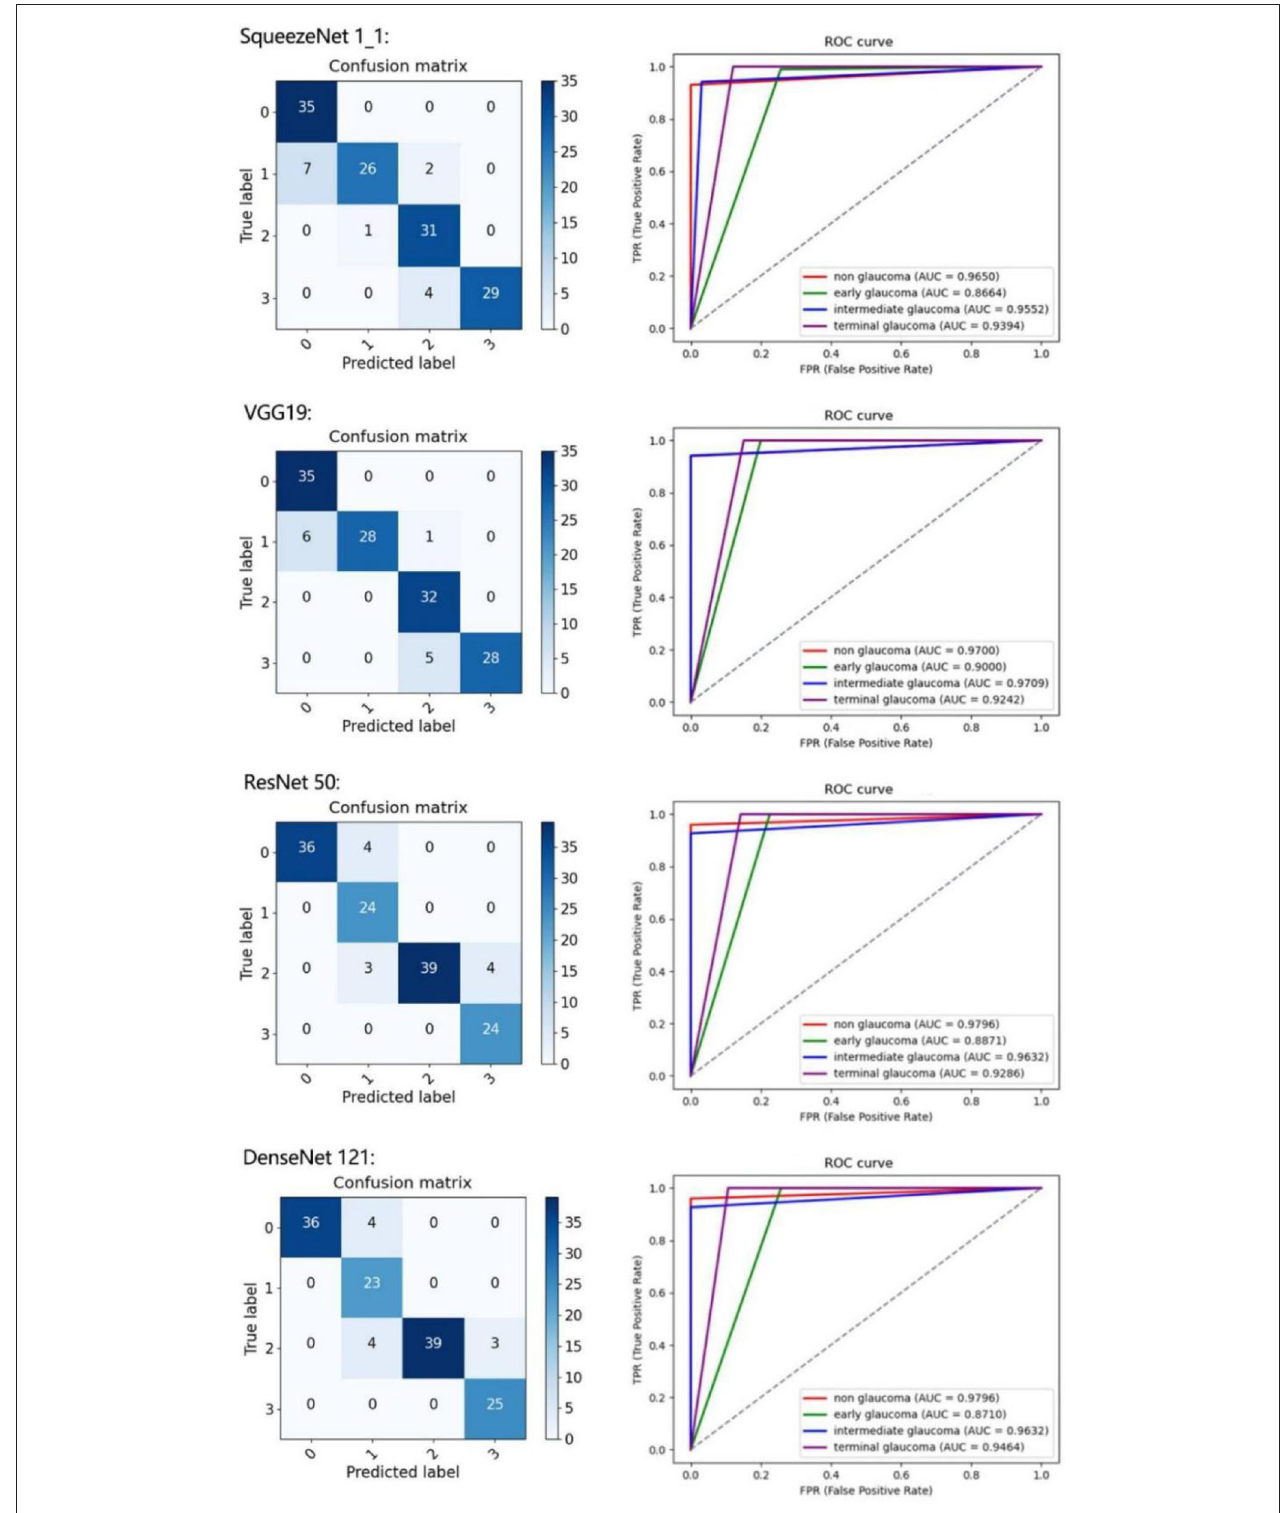
FIGURE 6 | Results of four classes on confusion matrix (left) and receiver operating characteristic (ROC) curves (right) for SqueezeNet1_1, VGG 19, ResNet 50, and DenseNet 121.